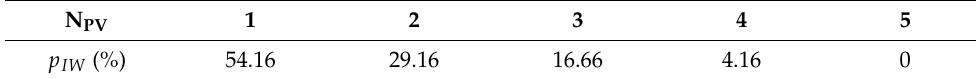
Table 7. p IW sensitivity to the number of PV arrays in the first scenario. N